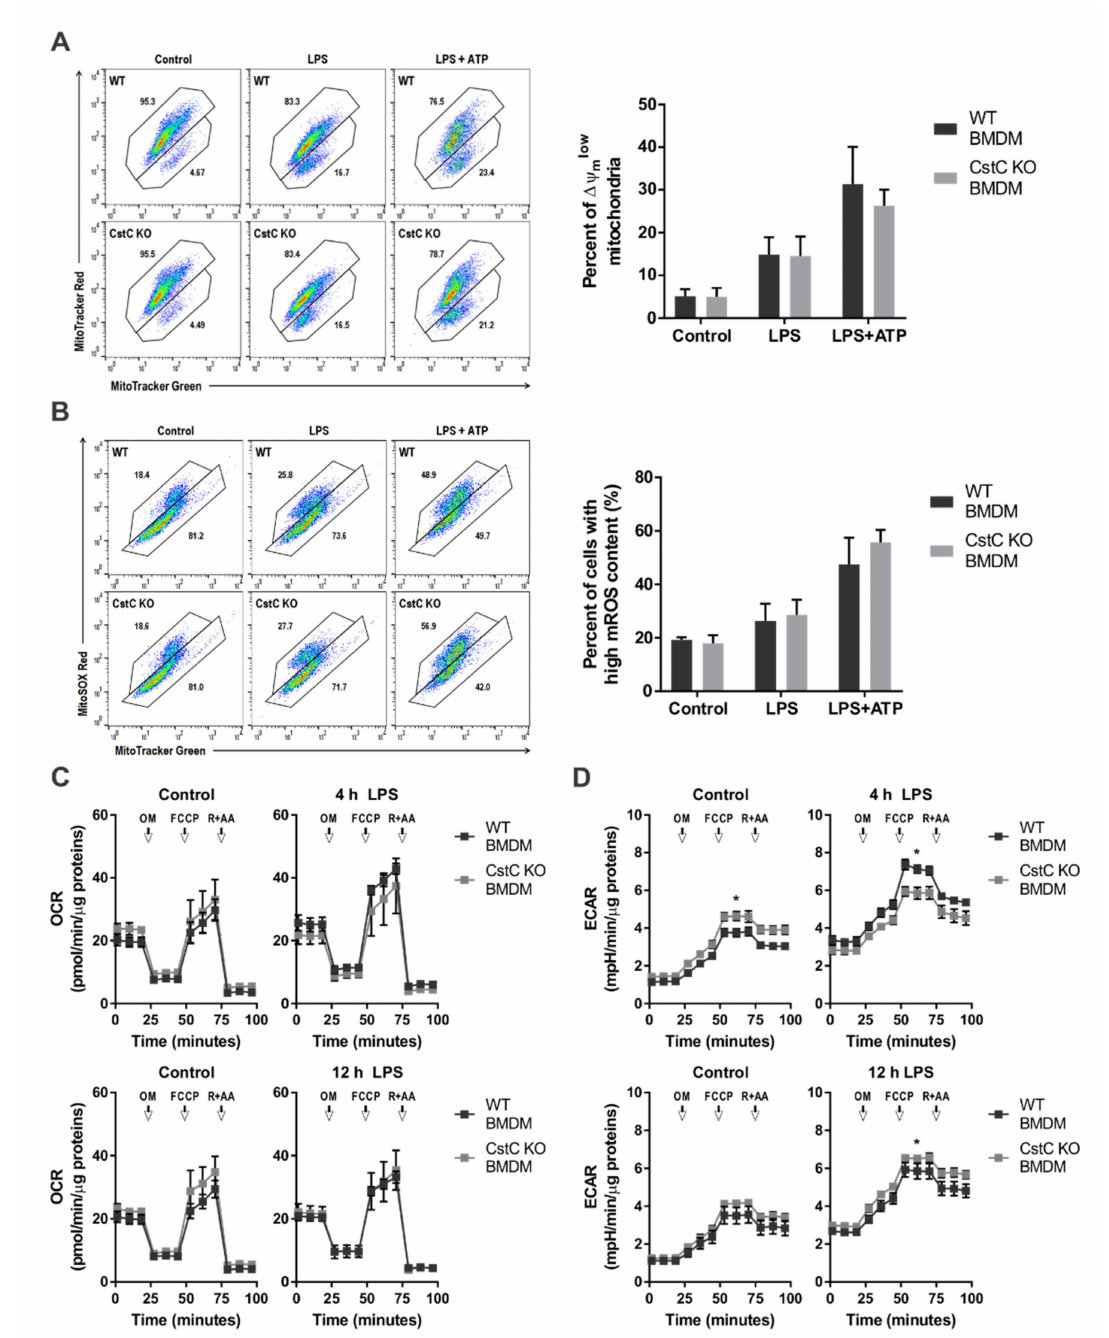
Figure 4. Cystatin C deficiency does not compromise mitochondrial membrane potential and generate mtROS. ( A ) and ( B ) BMDMs were primed for 4 h with LPS (100 ng/mL) and stimulated for 20 min with ATP (5 mM), as indicated. ( A ) Mito- chondrial membrane potential ( ∆ ψ m) was analyzed in cells labelled with MitoTracker Red CMXRos and MitoTracker Green. ( B ) ROS-producing mitochondria were analyzed in cells labelled with MitoSOX Red and MitoTracker Green. Data shown are representative of three independent experiments performed in duplicate, and the results are presented as means ± S.D. ( C ) and ( D ) BMDMs were stimulated with LPS (100 ng/mL) or vehicle (control) for 4 and 12 h. Mito stress test was then performed in Seahorse analyzer with oligomycin (OM) (1.5 µ M), FCCP (1.5 µ M) and rotenone + antimycin A (R+AA) (each 0.5 µ M). Data shown are of three biological samples performed in single or duplicate, and the results are presented as means ± S.D. * p < 0.05 (two-way ANOVA with Bonferroni’s